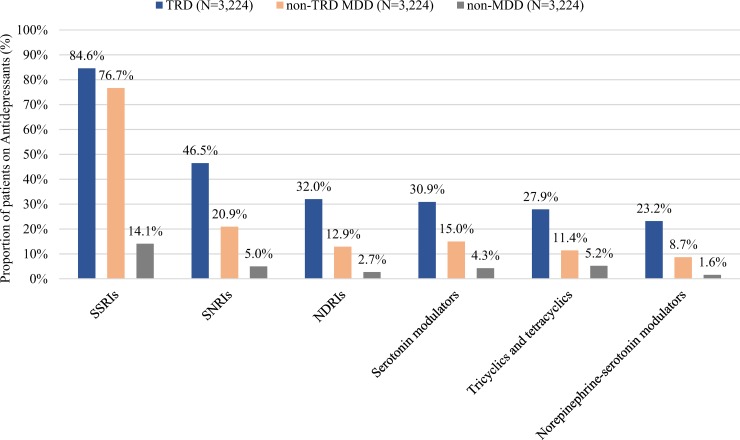
Antidepressant treatment patterns observed during the follow-up period for the TRD, non-TRD MDD, and non-MDD cohorts (main analysis).Abbreviations: MDD = major depressive disorder; NDRI = norepinephrine-dopamine reuptake inhibitors; SSRI = selective serotonin reuptake inhibitors; SNRI = serotonin-norepinephrine reuptake inhibitors; TRD = treatment-resistant depression.